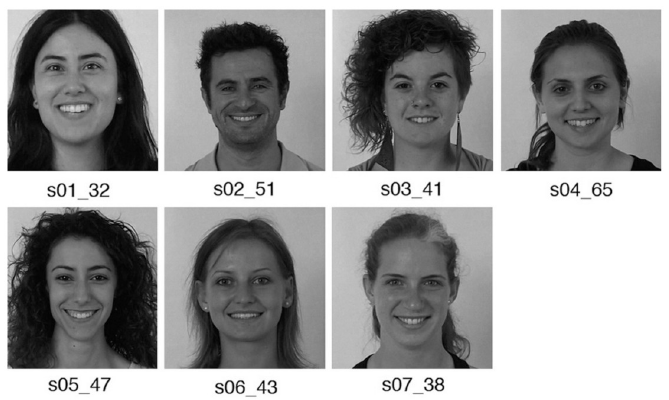
Fig 7. Open-mouth smile performed by different